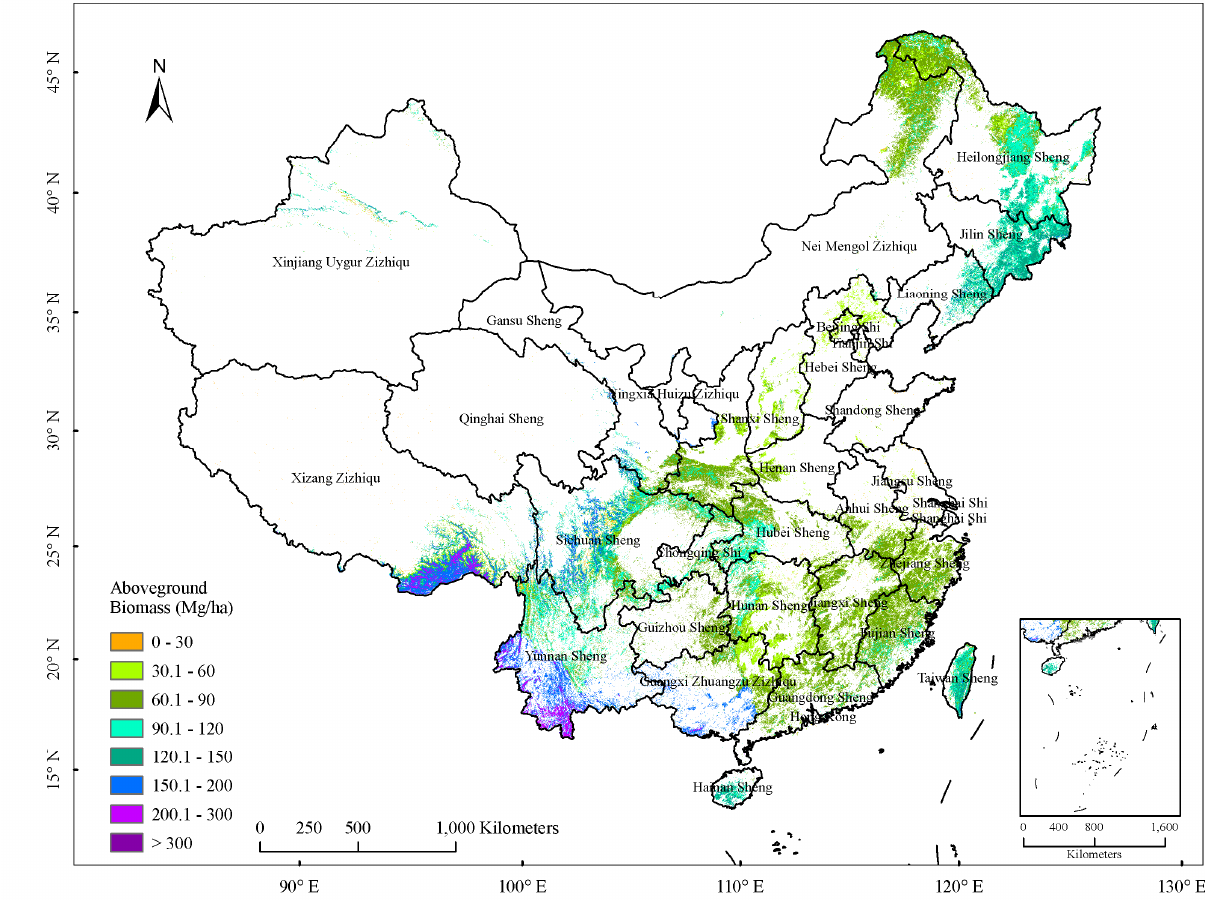
Figure 5. Map of aboveground biomass of Chinese forest. (The word “sheng” is spelled in Chinese Pinyin, and means “province” in English; similar to “shi” and